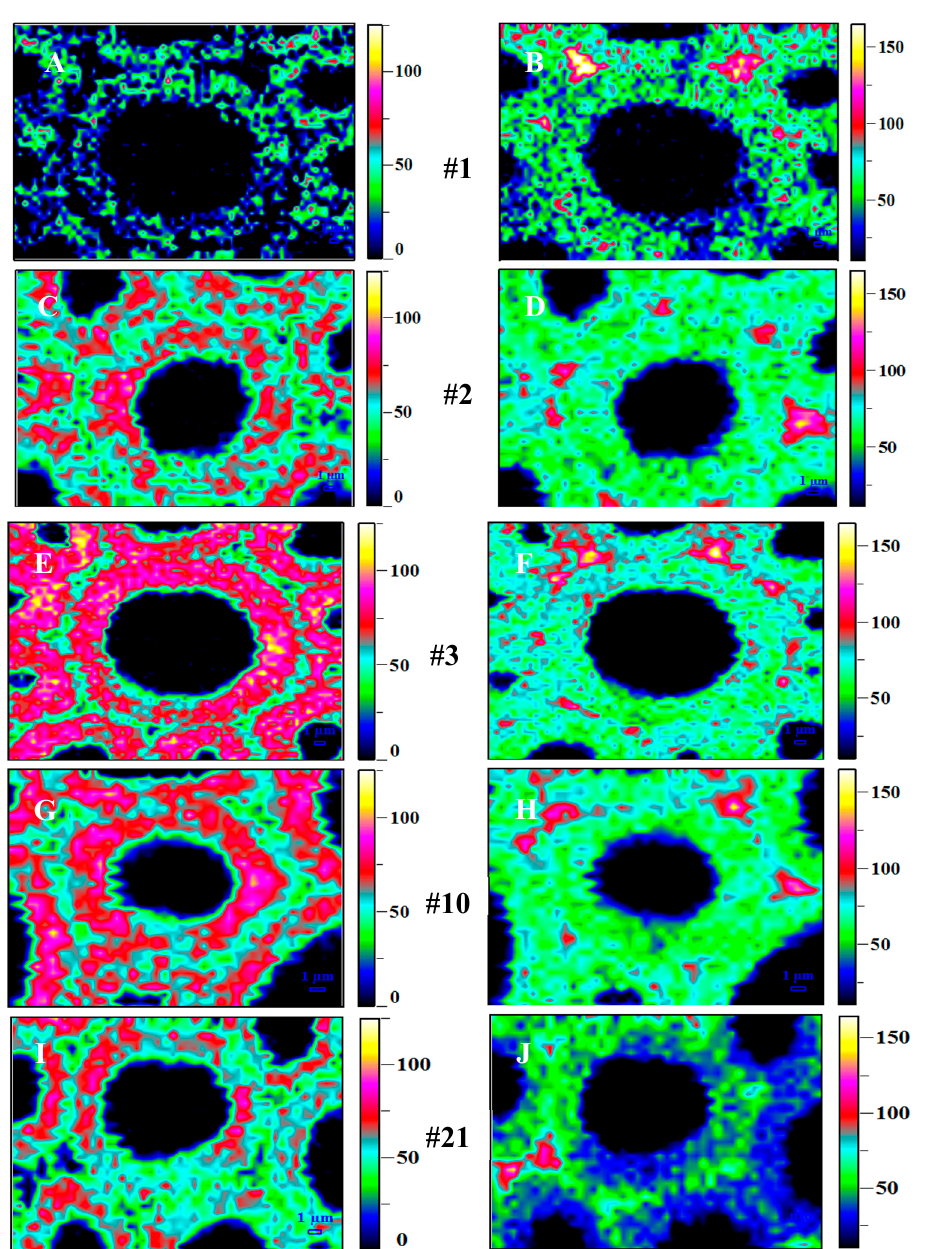
Figure 7. Raman images calculated by integrating from 2920 to 2768 cm –1 ( A , C , E , G , I carbohydrates) and from 1660 to 1540 cm –1 ( B , D , F , H , J lignin). ( A and B ) in Row #1 are the Raman imaging for the 1st sample splint showed in Figure 3A, a2. ( C and D) (in Row #2), ( E and F) (in Row #3), ( G and H) (in Row #10), and ( I and J) (in Row #21) are the Raman imaging for the 2nd, 3rd, 10th, and 21st sample splints. respectively.